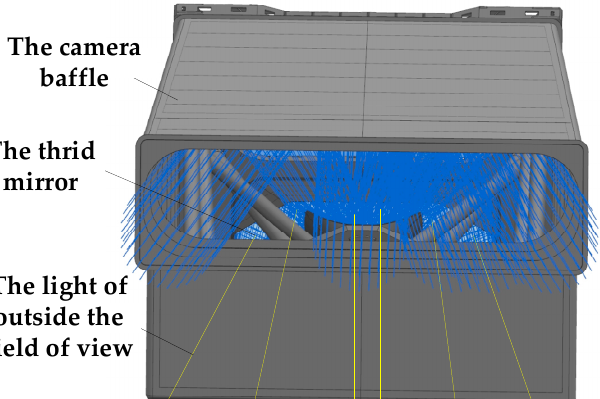
Figure 9. Schematic diagram of the third mirror directly irradiated by the light outside the field of view.